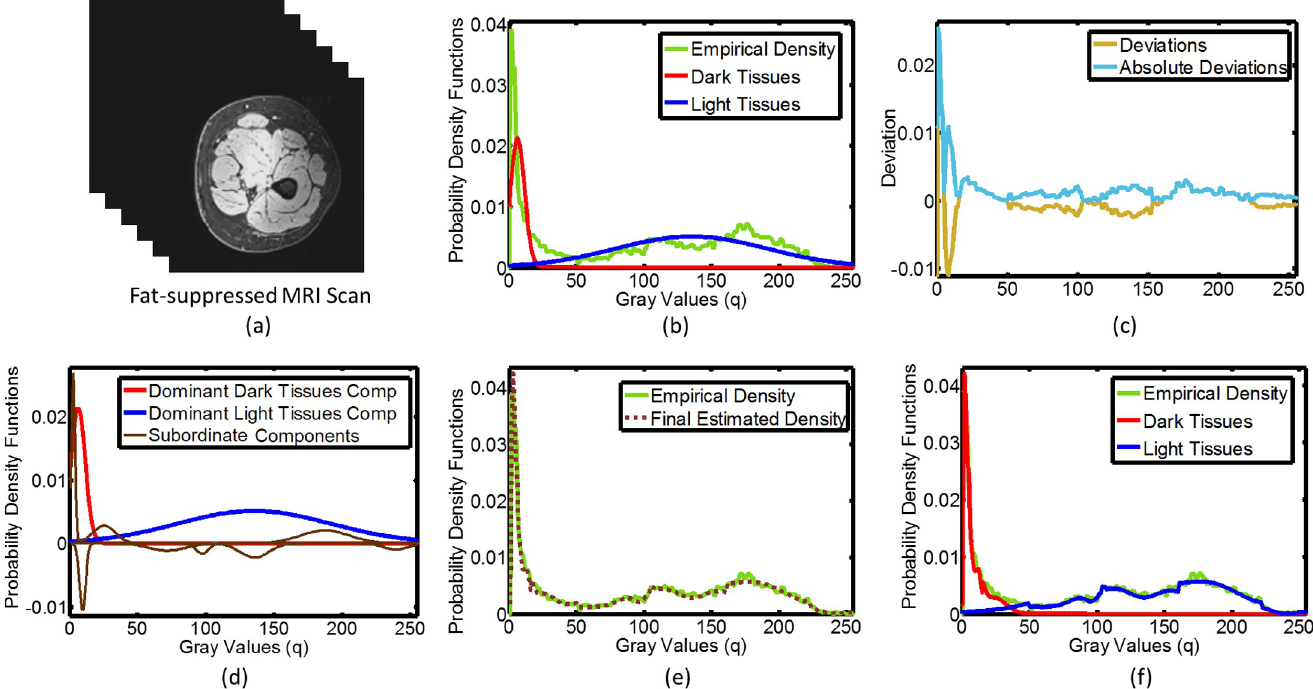
Fig 2. An Example for applying LCDG algorithm MRI 3-D volumes. LCDG algorithm output on (a) exemplary 3D FS-MRI image data; (b) probability density functions of the image voxels in Fig 2A, as determined empirically, and as approximated via LCDG using two dominant DGs; (c) the deviations (standard and absolute) between the empirical and estimated marginal probability density functions in Fig 2B; (d) LCDG algorithm output on the dominant and subordinate DGs in the image data in Fig 2A; (e) the final estimated LCDG model of the empirical density function; and (f) the final LCDG output of the conditional probability density functions of light tissue (muscle) and dark tissue (fat) intensities and the empirical density function.